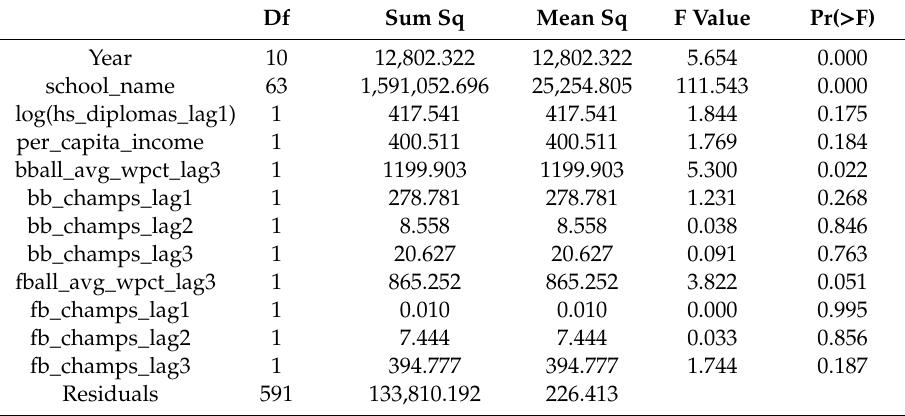
Table A2. ANOVA table for SAT75p.